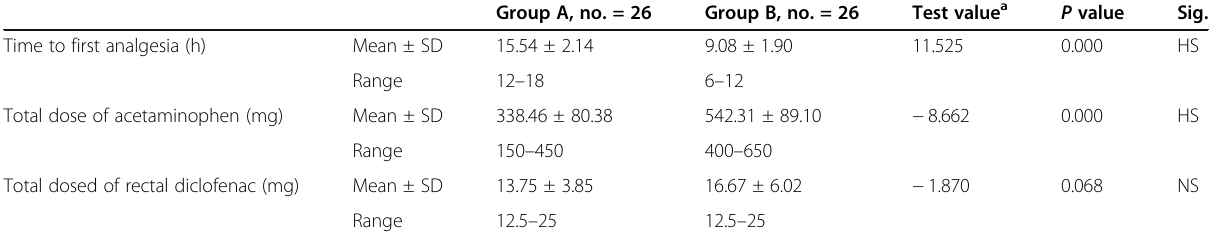
Table 5 Comparison between group A and group B regarding time to first analgesia given and total dose of analgesia Group A, no. =